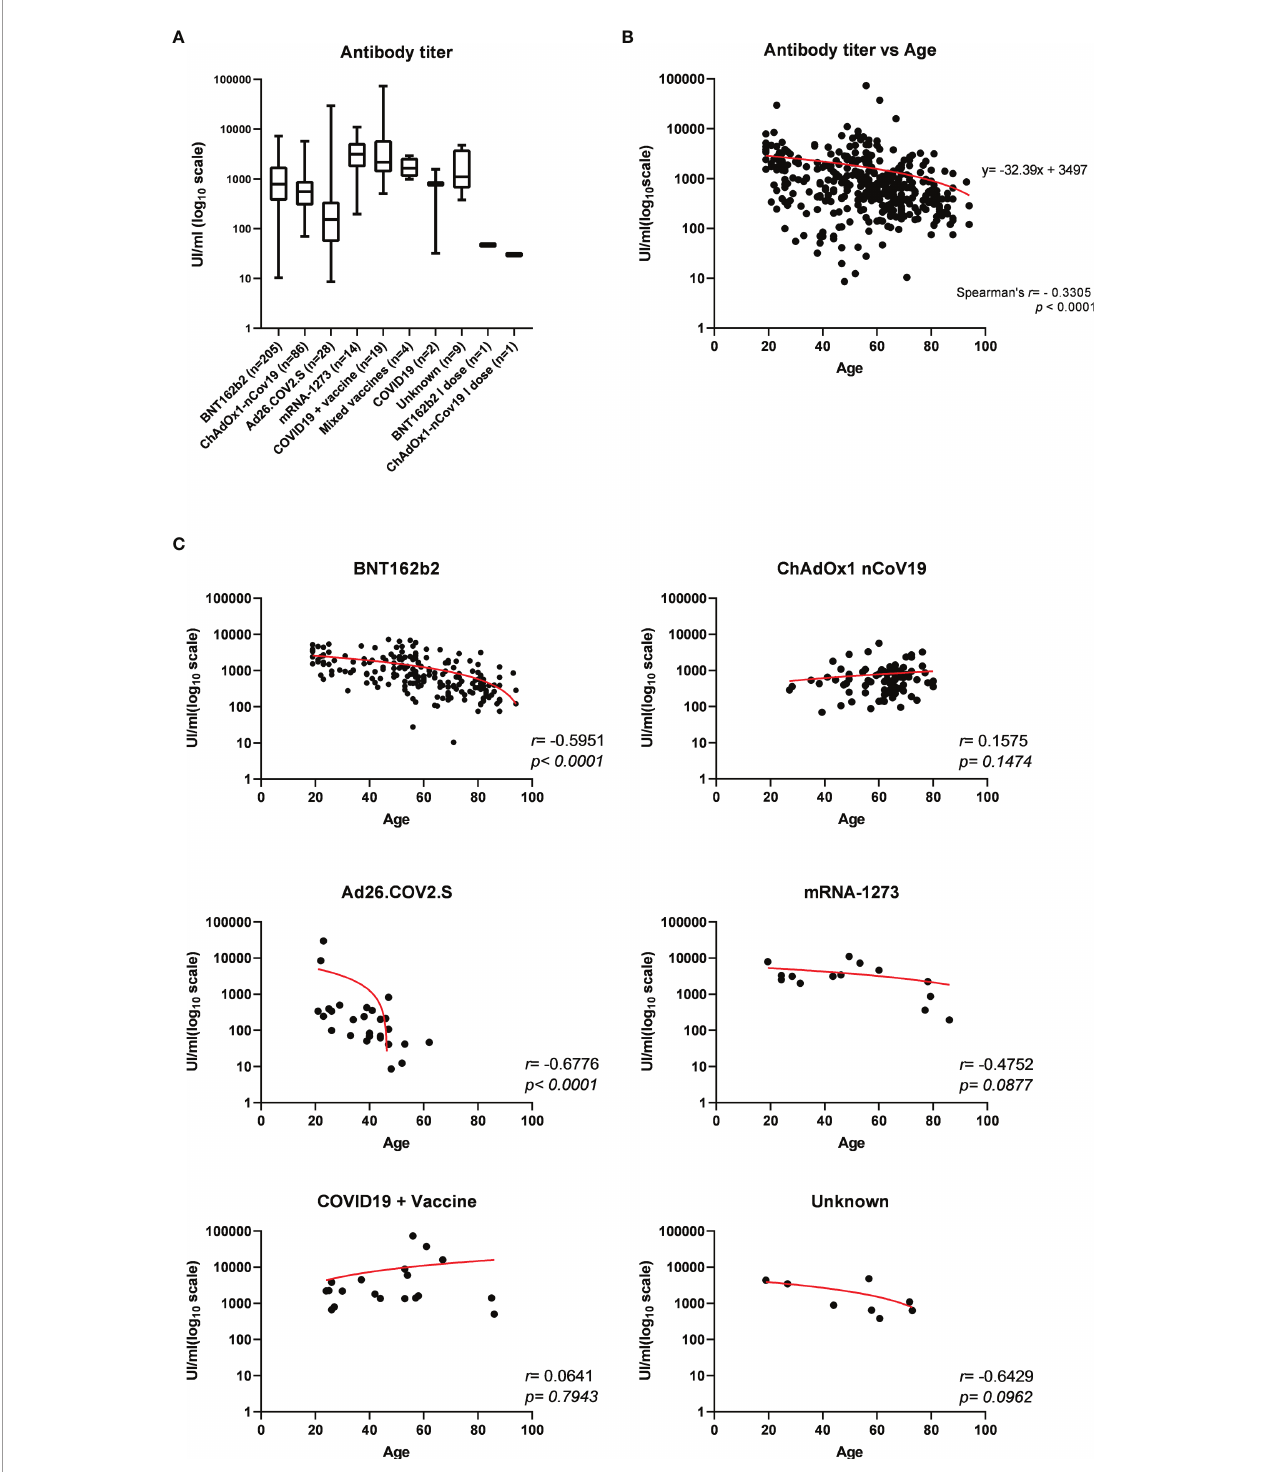
FIGURE 1 | (A) Electrochemiluminescence immunoassay (ECLIA)-based determination of the titer of speci fi c antibodies towards the receptor-binding domain (RBD) of SARS-CoV-2 Spike expressed as median UI/ml ± IQR and represented on log10 scale, evaluated in serum from 369 individuals who received different vaccination. Statistically signi fi cant variations of medians were assessed by Kruskal – Wallis method for non-parametric data ( p < 0.0001), followed by Dunn ’ s multiple comparisons test. (B) Distribution of serum anti-RBD antibody titers according to age among the study population and (C) within each vaccination group. Spearman ’ s correlation r and p -values have been calculated for each group (statistical signi fi cance for p < 0.05). Trendline is represented in